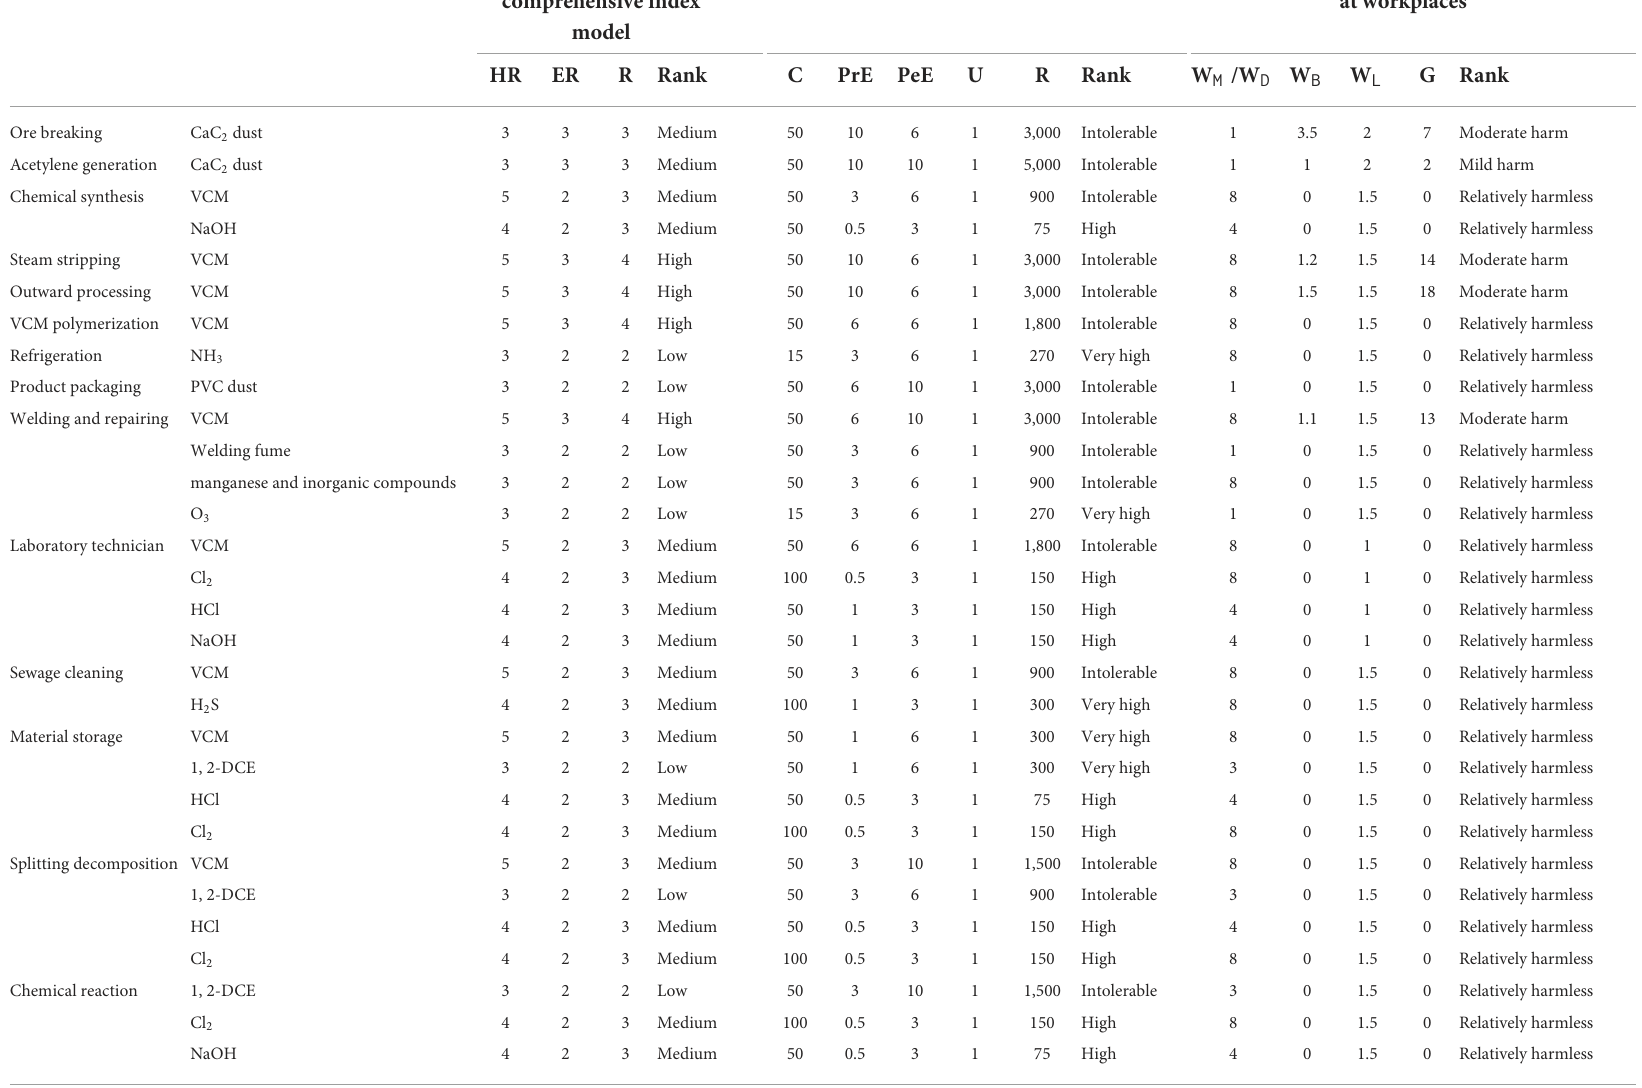
TABLE 6 Comparison results among three risk assessment models in 2020.